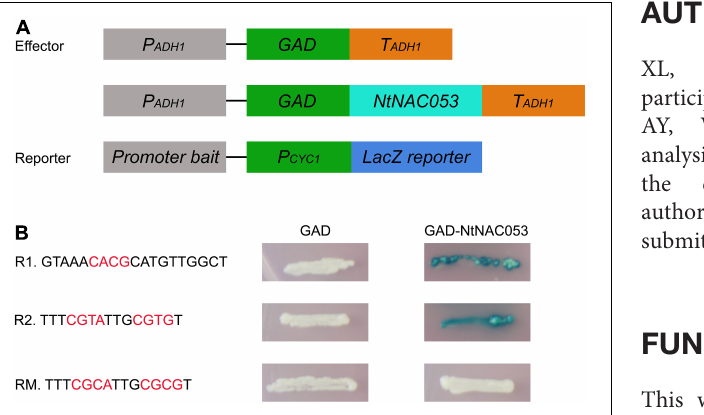
Supplementary Figure 1 | Multiple sequence alignment of NtNAC053 with reported NAC proteins from Arabidopsis and potato, including ANAC002, ANAC081, ANAC029, ANAC072, ANAC055, ANAC019, and StNAC053. The black lines indicated five subdomains (A–E) and nuclear location signal (NLS). Supplementary Figure 2 | The phylogenetic, syntenic analysis and motif organization of NtNAC053. (A) The phylogenetic tree was generated based on the amino acid sequences of NtNAC053 and other reported NAC proteins. (B) The motif organizations were predicted by MEME. (C) The gray line in the background represents the collinear blocks between tobacco and potato, while the red line exhibits the syntenic NAC gene pairs. Supplementary Figure 3 | The putative conserved motifs in NAC proteins. Supplementary Figure 4 | The cis -acting element analysis of the promoter regions of NtNAC053 gene. Supplementary Figure 5 | The expression level of the NtNAC053 gene in wild type and two overexpression lines, the ratios of gene expression levels were calculated relative to the wild type. Supplementary Figure 6 | Expression of NtAQP1 in overexpression lines and wild-type tobacco under drought stress. The ratios of gene expression levels were calculated relative to the control, respectively. Supplementary Figure 7 | Analysis of H 2 O 2 contents in overexpression lines and wild-type tobacco under salt and drought stresses. H 2 O 2 , hydrogen peroxide. WT, wild type. Supplementary Figure 8 | Expression of NtNHX1 and NtSOS1 in overexpression lines and wild-type tobacco under salt stress. The ratios of gene expression levels were calculated relative to the control, respectively. WT, wild type. Supplementary Figure 9 | The expressions of ABA signaling genes in overexpression lines and wild-type tobacco under salt and drought stresses. The ratios of gene expression levels were calculated relative to the control, respectively. WT, wild